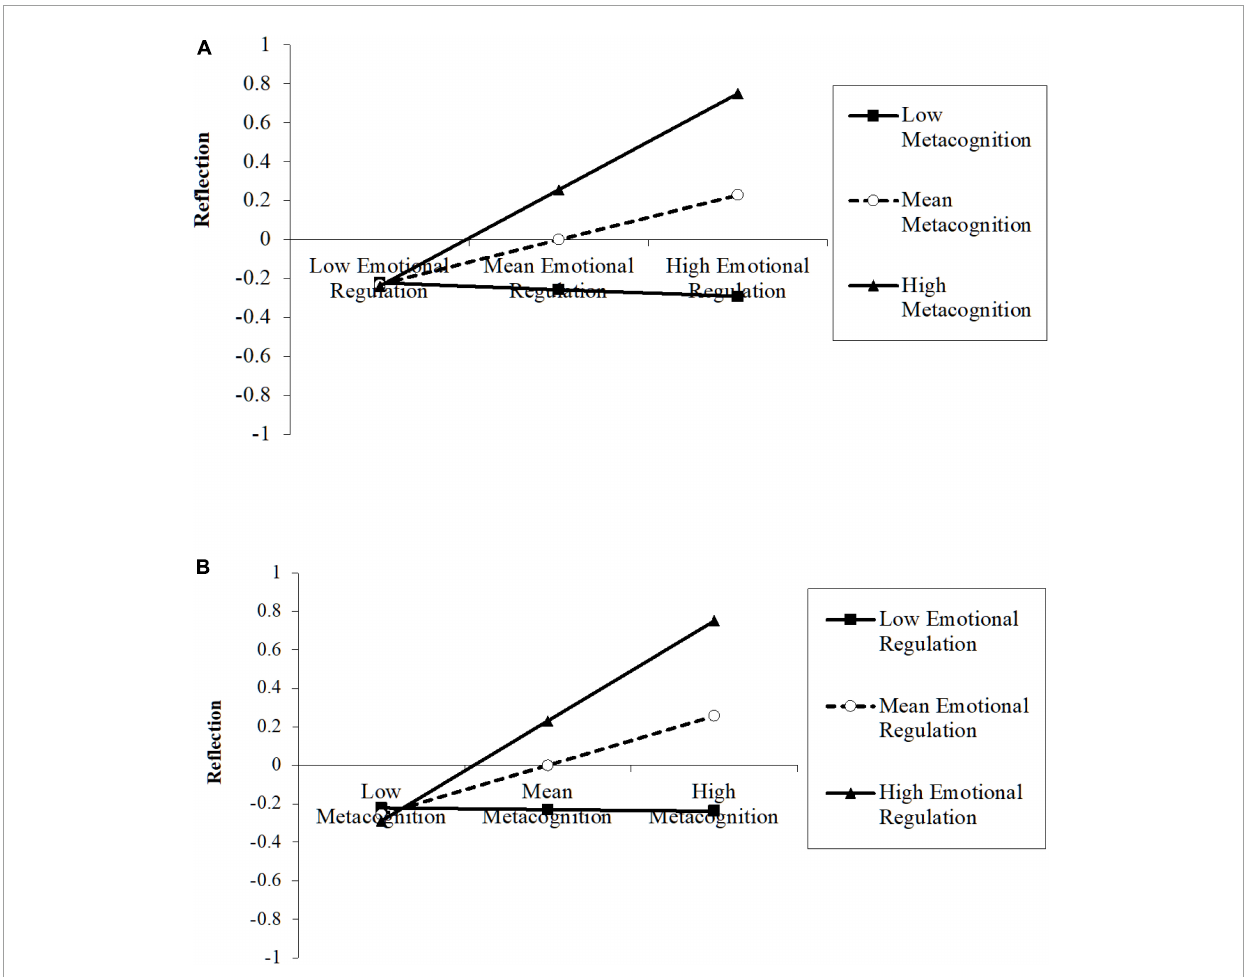
FIGURE3 The interaction between metacognition and emotional regulation on reflection. Panel (A) shows the moderation role of metacognition and panel (B) shows the moderation role emotional